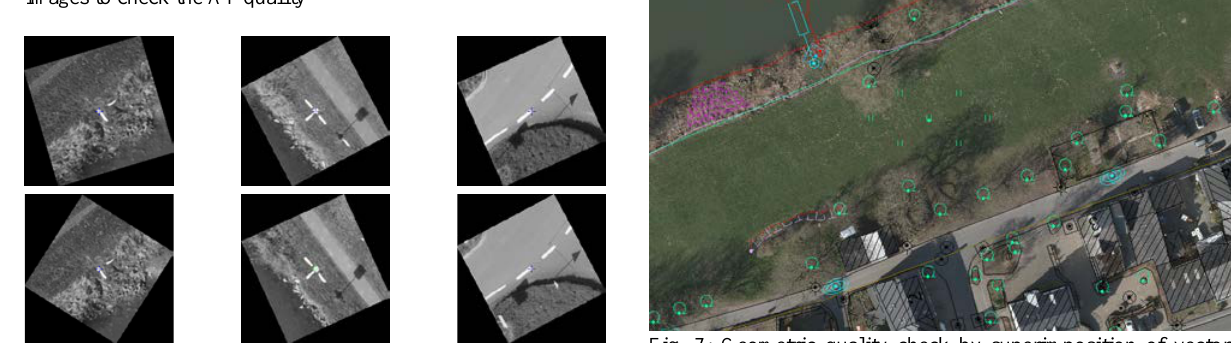
Fig. 5: Image chips (raw images) in oriented images A check of the geometric quality of intermediate generated single DOPs before the mosaicking can be done by comparing the generated single DOPs in the overlapping zone (Fig. 6). The geometric accuracy can also be determined by detecting residues between two adjacent overlapping orthophotos. The single DOPs have to be checked by visual inspection: Are there unnatural deviations in curvature of lines (Fig. 8), are the luting due to steepness of the terrain (Fig. 10), or duplications?